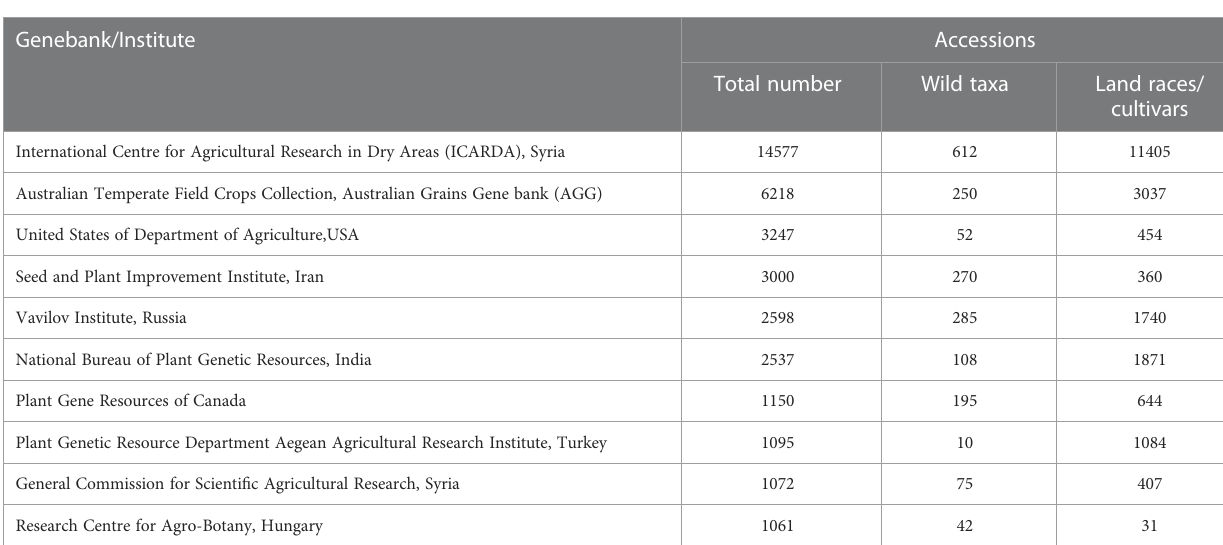
TABLE 1 List of World Germplasm Collections in